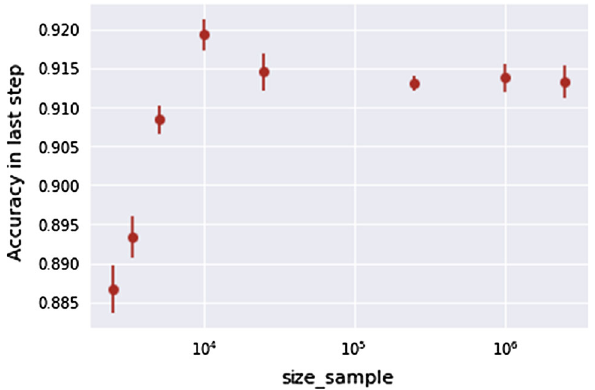
Fig. 9 Thedependenceoftheaccuracyinthelastiterationoftheactive learning procedure on the number of candidates and the number of points selected for querying to the oracle in each iteration. The last iteration was defined as the last iteration before 100,000 data points were selected, meaning that a setup with size_select equal to 500 had more iterations than a setup with a size_select of 7500 for